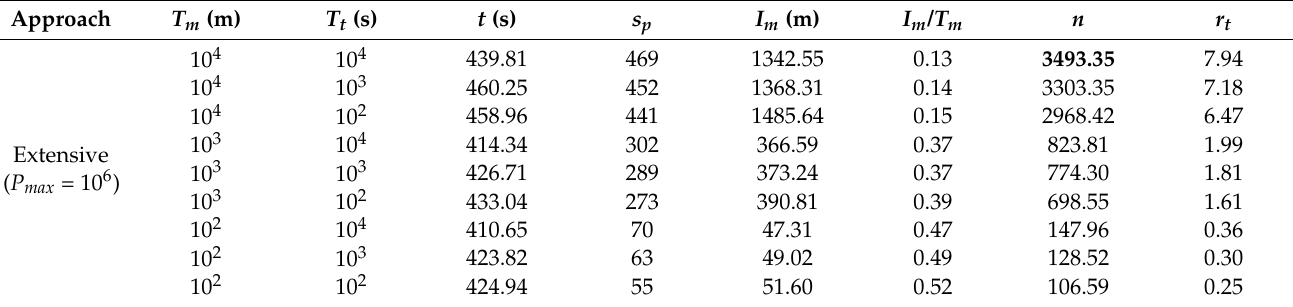
Table 5. Ship Pairing Comparison for ε = 1